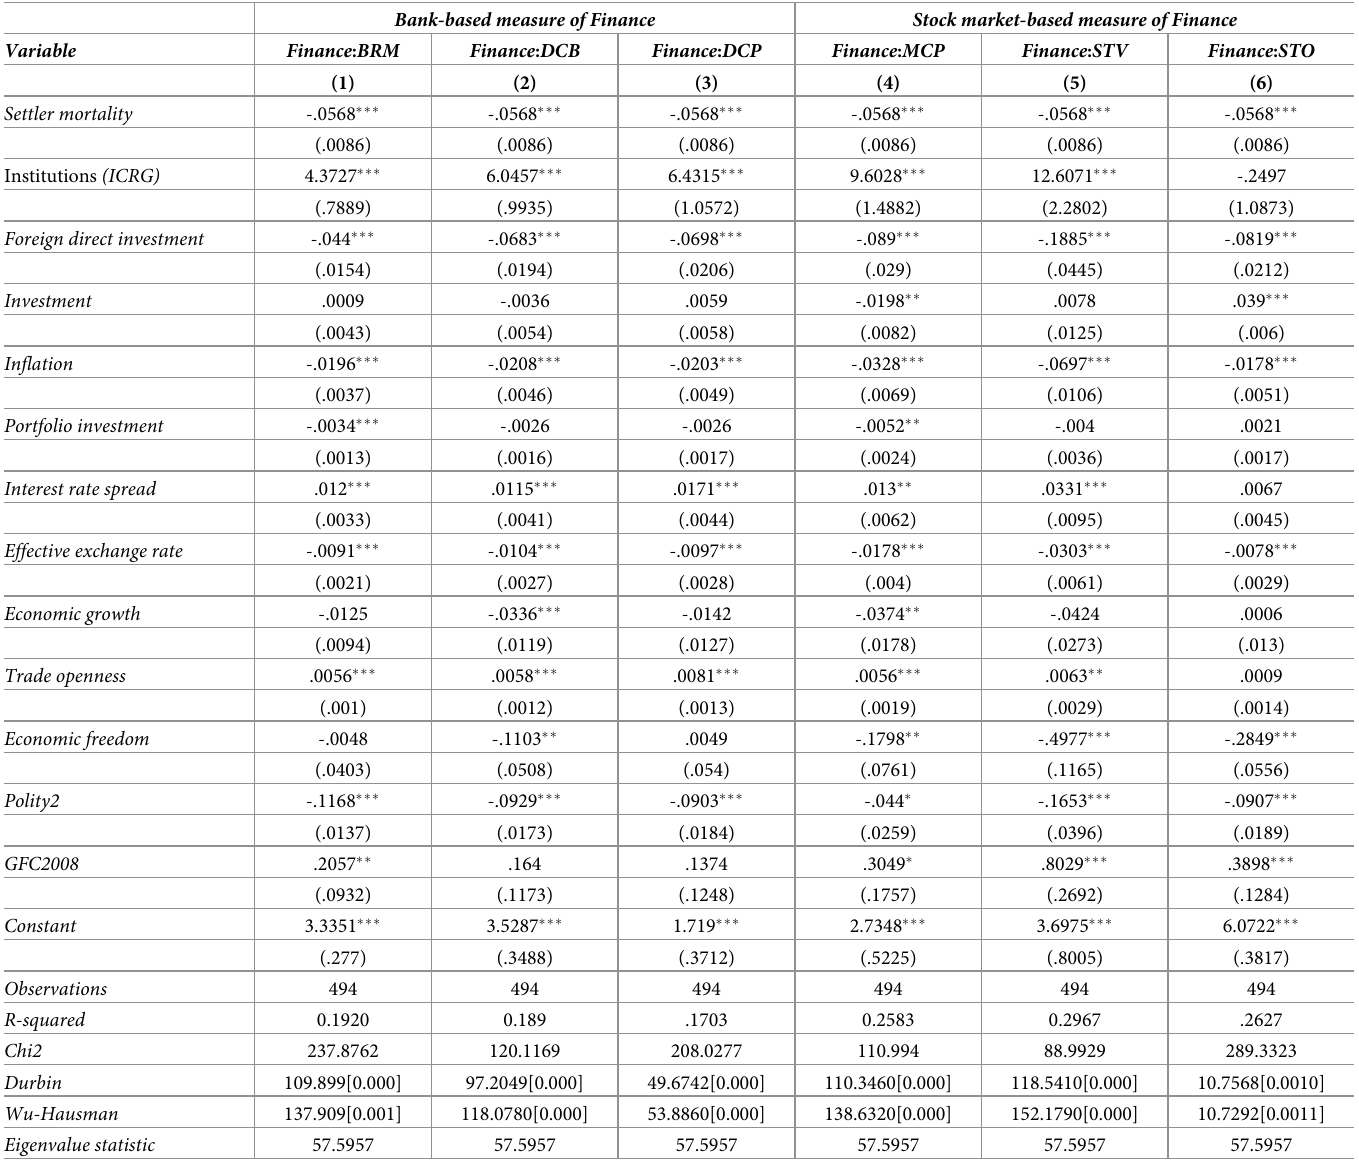
Table 6. Robustness with traditional measures of finance (2SLS